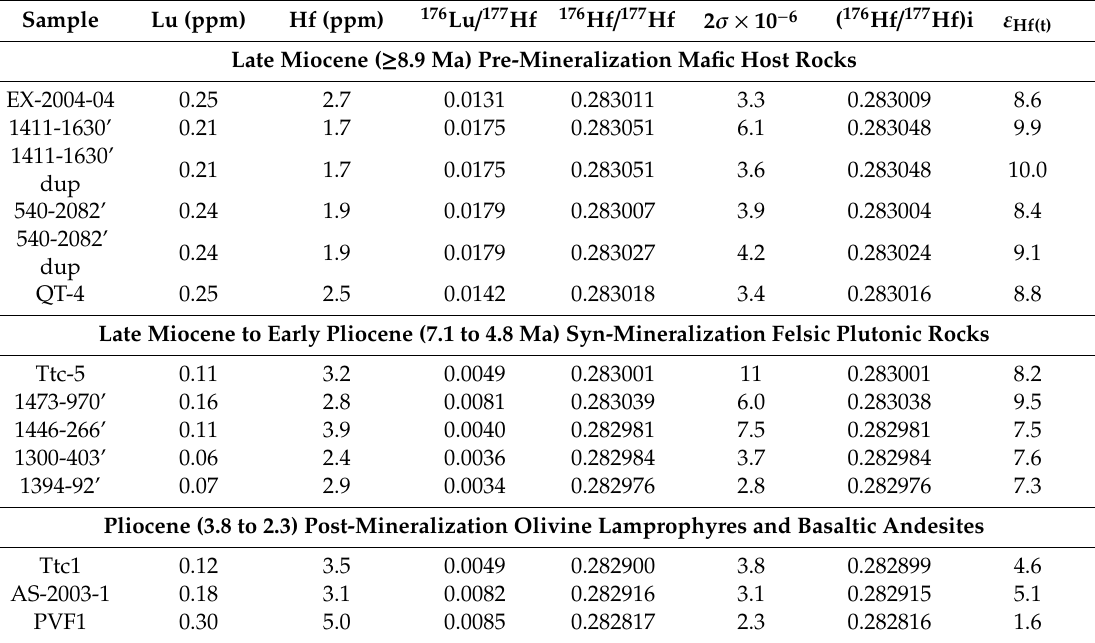
Table 4. Lu-Hf isotopes of the El Teniente